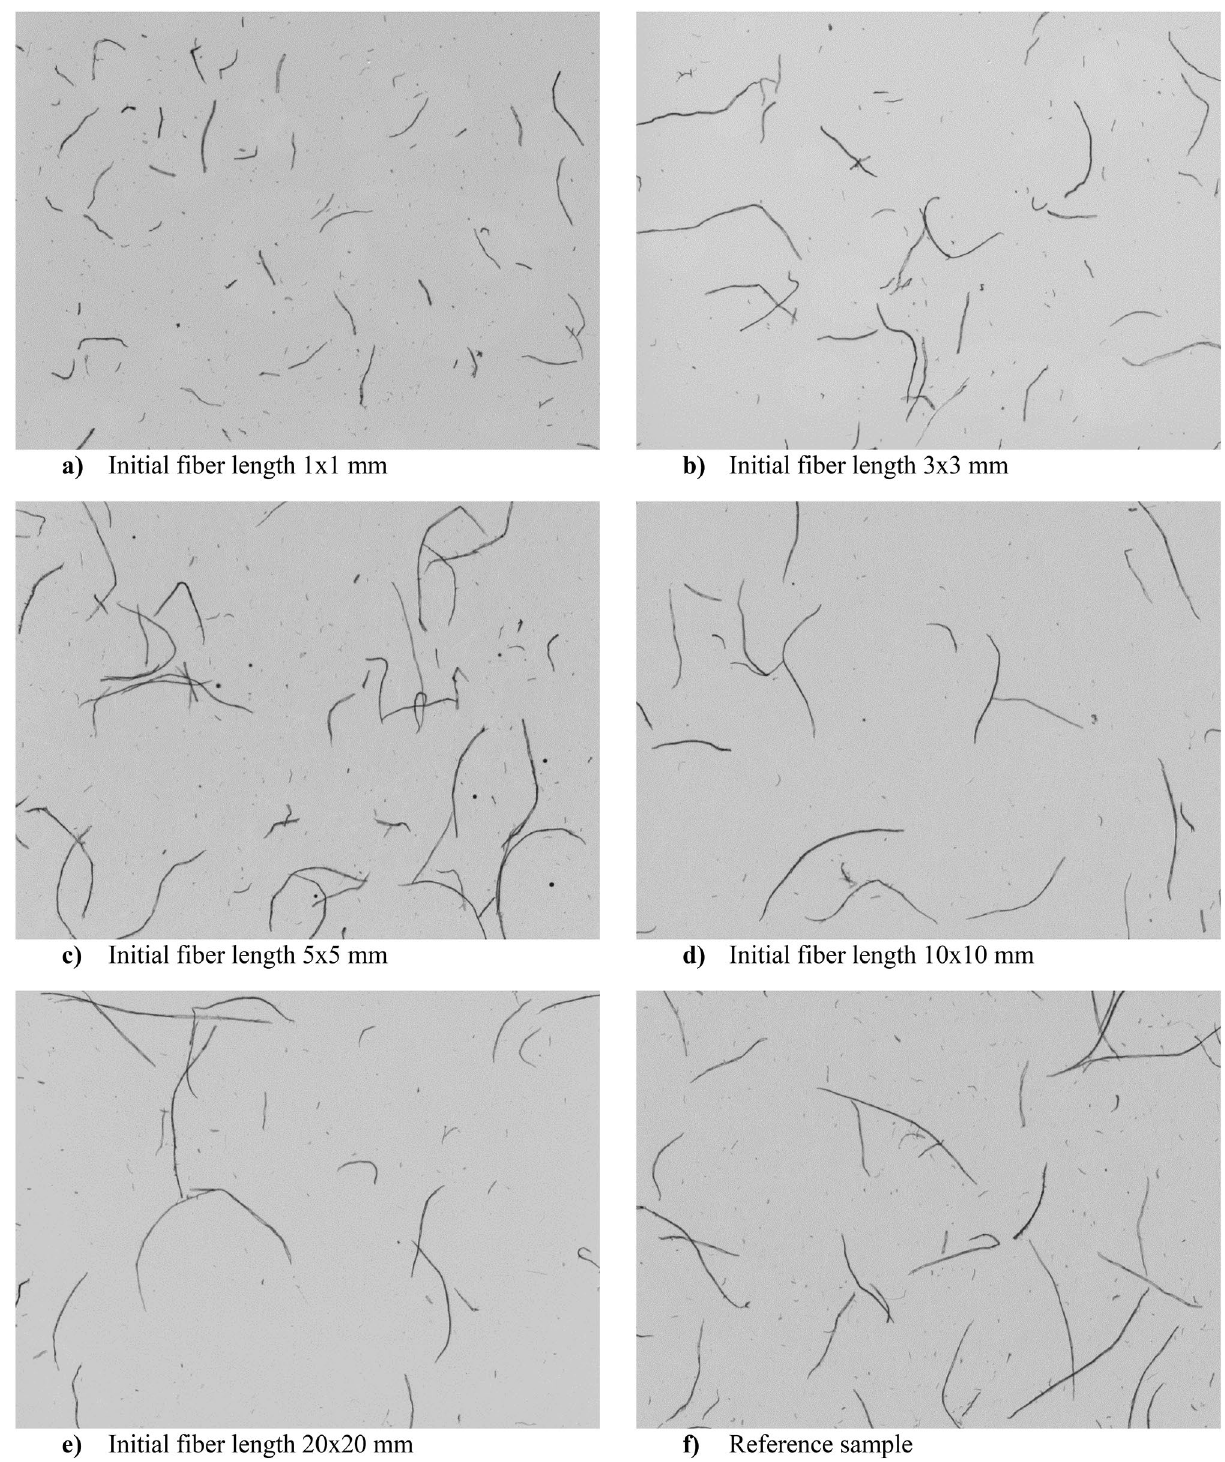
Figure 2. Microscopic images of tested fibrous